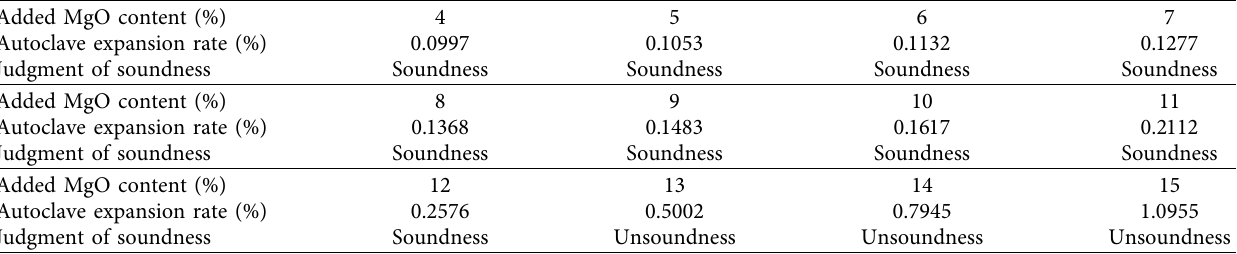
Table 3: Autoclave expansion rate of mortar specimens.